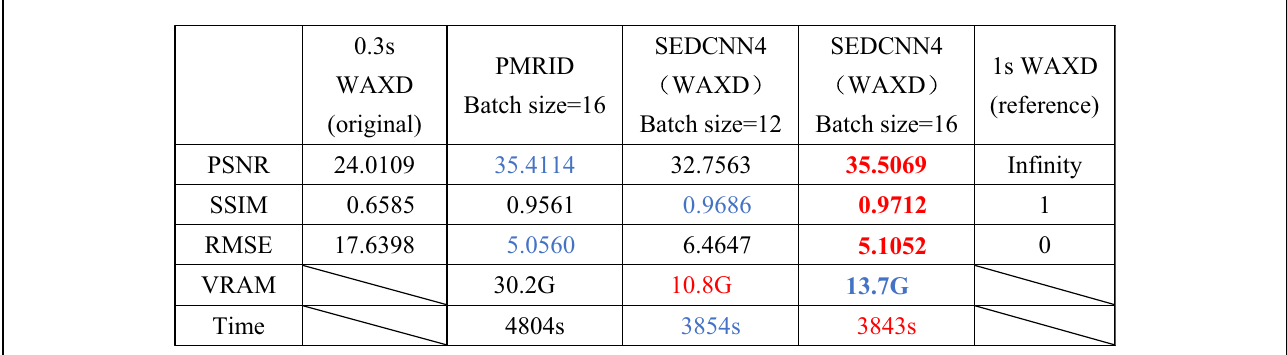
Table 2. Performance of SEDCNN4 (WAXD) compared to PMRID after 500 epochs.